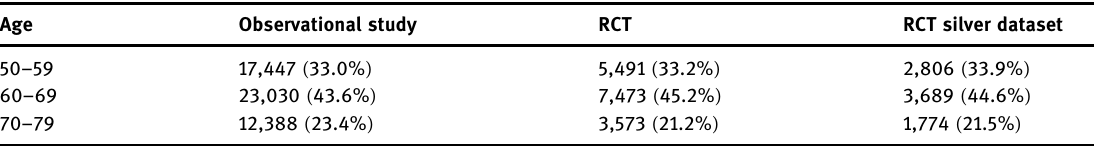
Table A7: Distribution of age variable values in the observational study, RCT, and RCT silver datasets Age